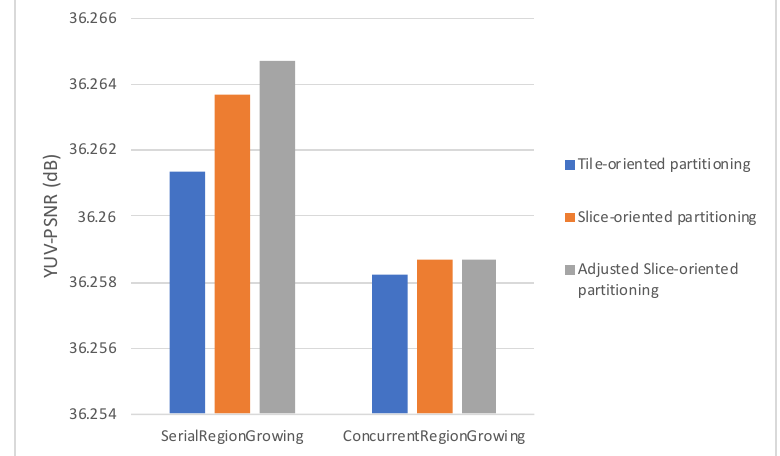
Figure 15. Average YUV-PSNR performance 5 regions.